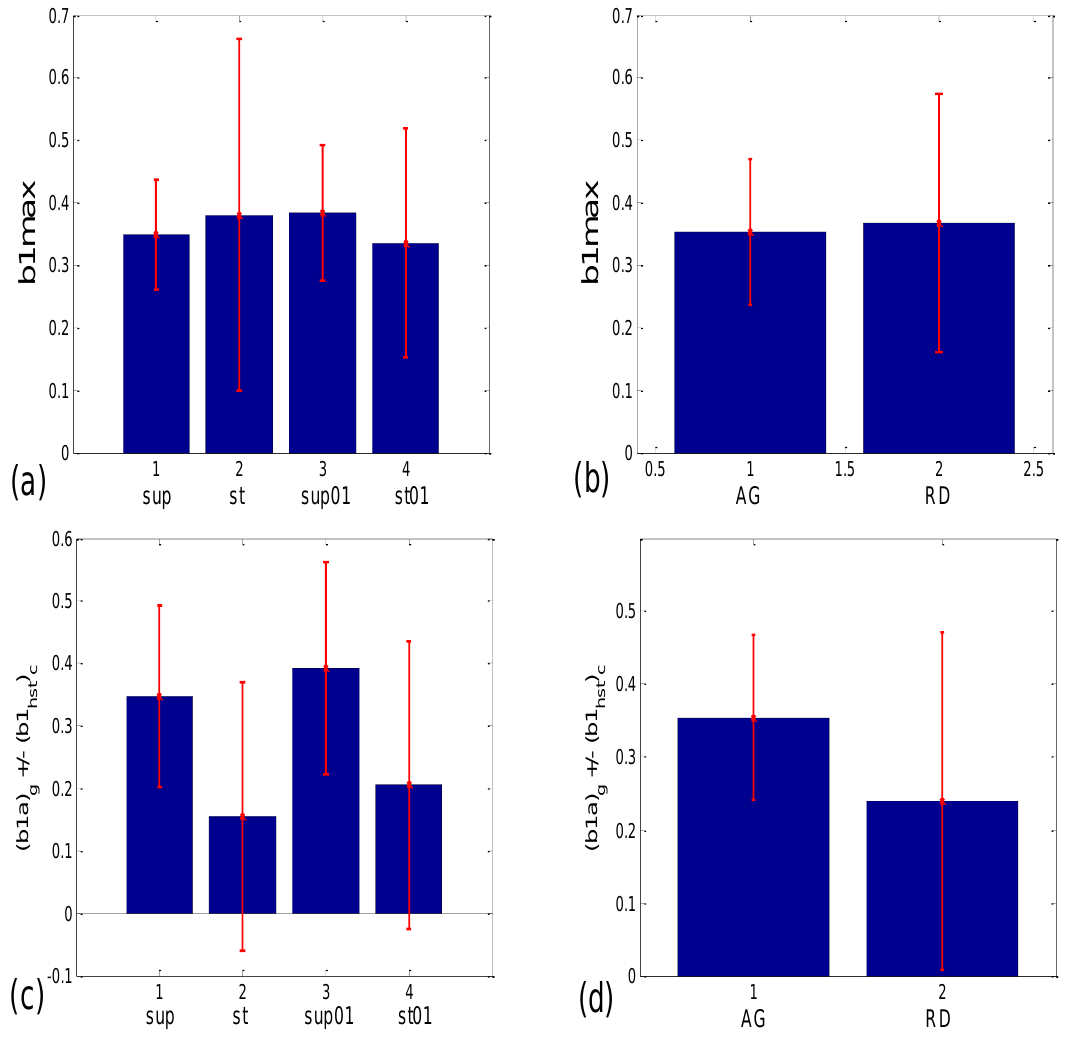
Figure 12. ( a , b ) Bar plots showing the results of the linear averaging of b1max (mean ± standard deviation); ( c , d ) ( b1a ) g — doubly angularly averaged from b1 ( i )) s , according to Equations (10) and (11), across all BBI ( i ) and all subjects ( s ); the error bars represent the circularly corrected standard deviations ( b1 hst ) c . ( a , c ) Statistics of the scatter plots in four experimental states; ( b , d ) the scatter plots shown according to the type of aggregation.